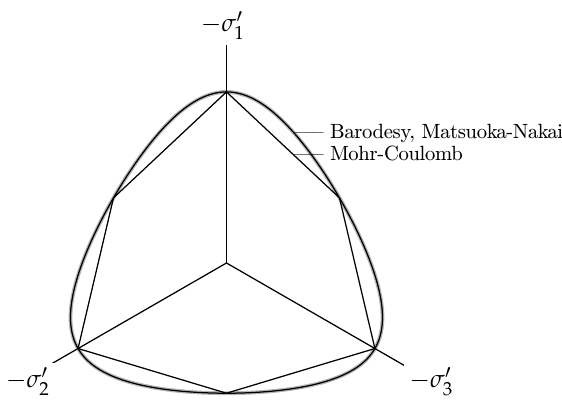
Figure 1. Matsuoka-Nakai and Mohr-Coulomb failure surface are compared with barodesy in the deviatoric plane. Barodesy and Matsuoka-Nakai practically coincide [11]. Figure modified from [12].